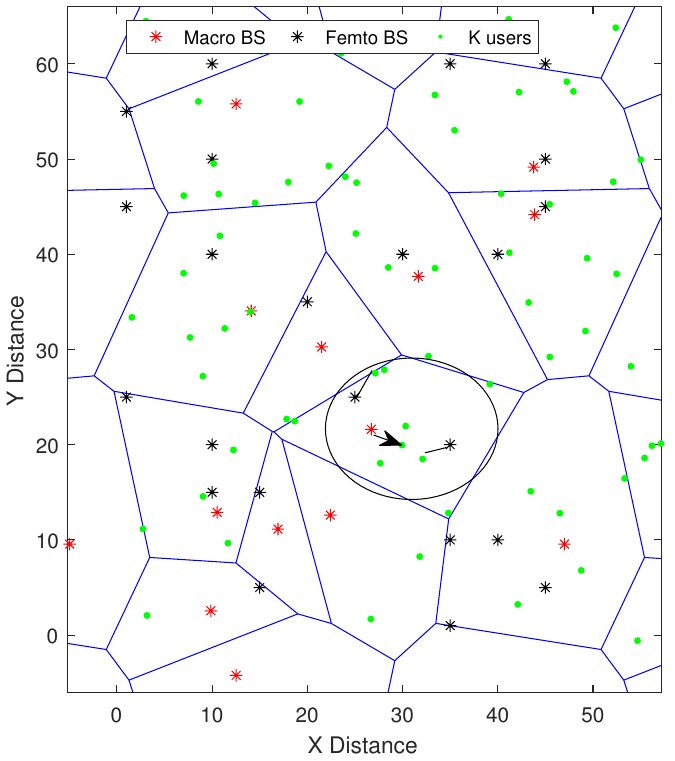
Figure 1. Models the PPP design with the understudy cluster wrapped